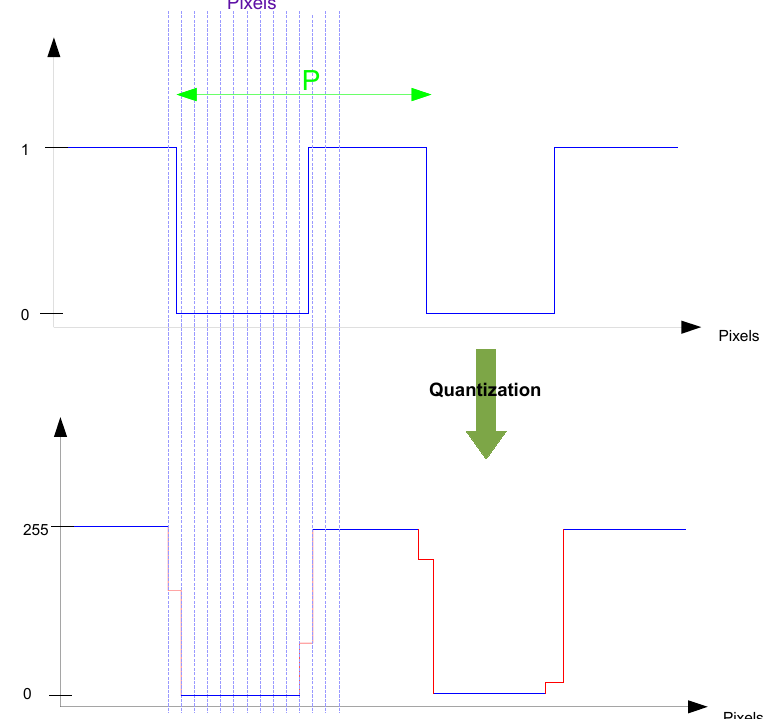
Figure 6. Illustration of the quantization principle applied to a perfect square grid; case of 8 bits sensor, with pixels encoded between 0 and